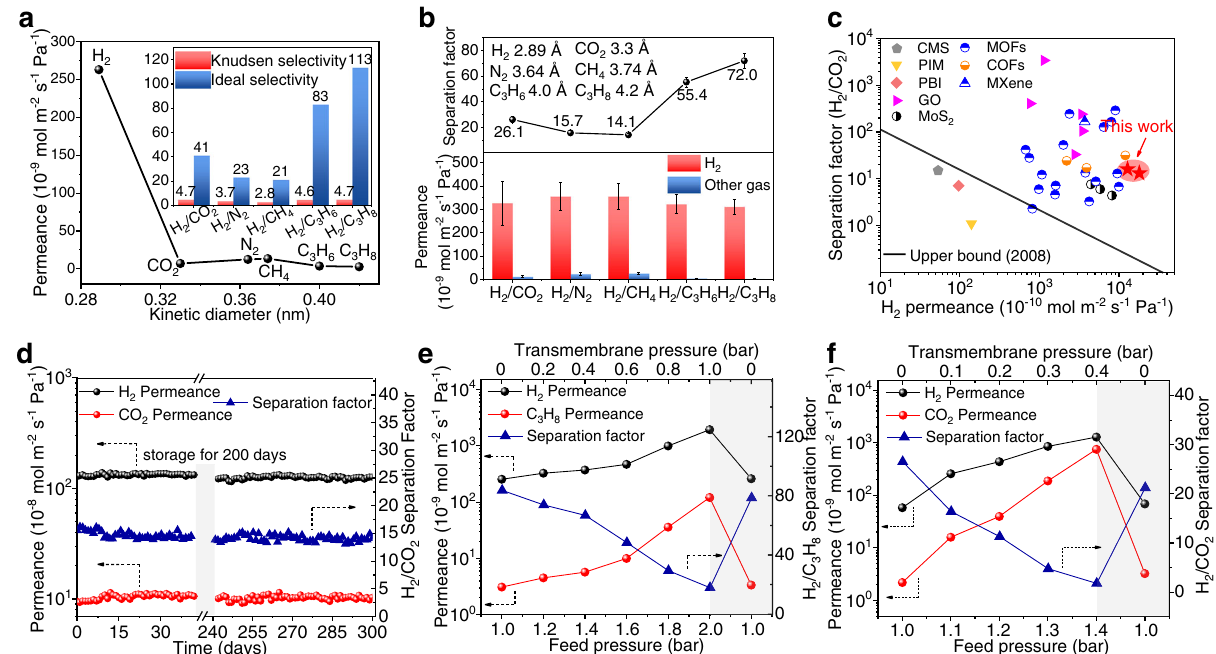
Fig. 3 | Gas separation performance through the g-C 3 N 4 membranes. a Single gas permeation of the 1- μ m-thick g-C 3 N 4 membrane at room temperature and 1bar.The inset shows the gas selectivity forH 2 overother gases. b Permeanceand separationfactorsofthe1- μ m-thickg-C 3 N 4 membranesintheequimolarmixed-gas permeation at room temperature and 1bar. Inset shows the kinetic diameters of various gas molecules. Errors bars indicate the standard deviation of three mea- surements. c Comparison of H 2 /CO 2 separation performance of g-C 3 N 4 mem- branes with state-of-the-art membranes at room temperature. d Long-term stability of the g-C 3 N 4 membrane for equimolar H 2 /CO 2 mixture. The gray areas